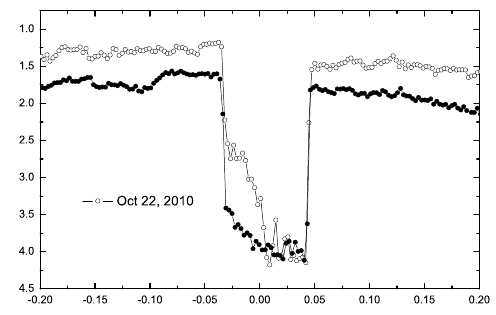
Figure 3: White-light eclipse profiles observed with the 1.0-m telescope in Yunnan observatories. Open cir- cles refer to the data obtained on Oct. 22, 2010, while solid dots to those obtained on Oct. 30.